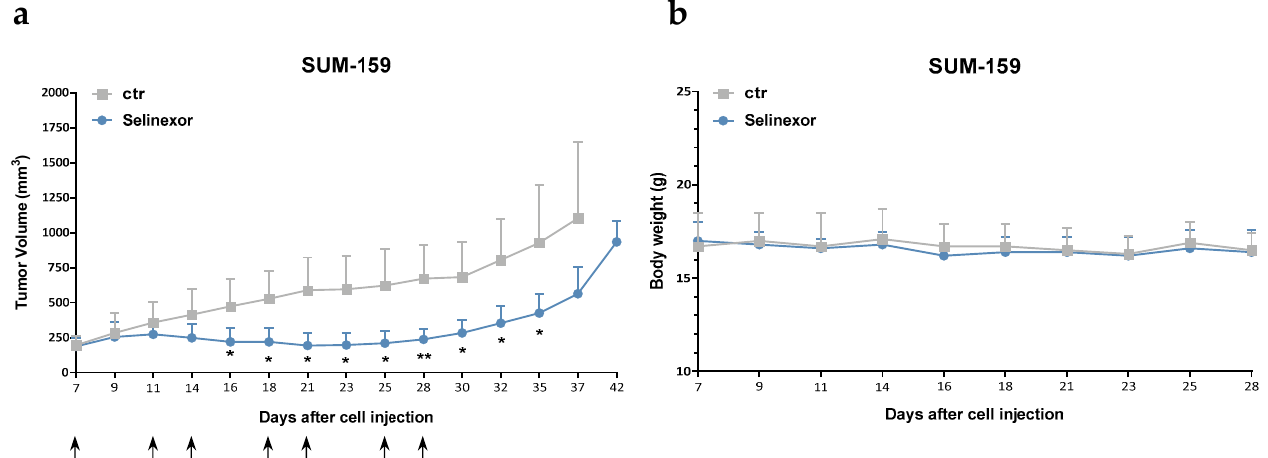
Figure 3. Efficacy of oral selinexor on TNBC xenografts. ( a ) Tumor growth curves of SUM-159 cells orthotopically injected into SCID mice. Mice were randomly grouped (6 mice/group) to receive vehicle (ctr) or selinexor (10 mg/kg, q3-4d × 8). Each point indicates the mean tumor volume in the group. Bars represent SD. Arrows indicate the day of the treatment. ( b ) Body weights of mice during the treatment period. Each point indicates the mean weight of mice in each group. Bars represent SD. * p < 0.05, ** p < 0.01, Student ′ s t -test. Table 2. Anti-tumor activity of selinexor in TNBC xenografts.